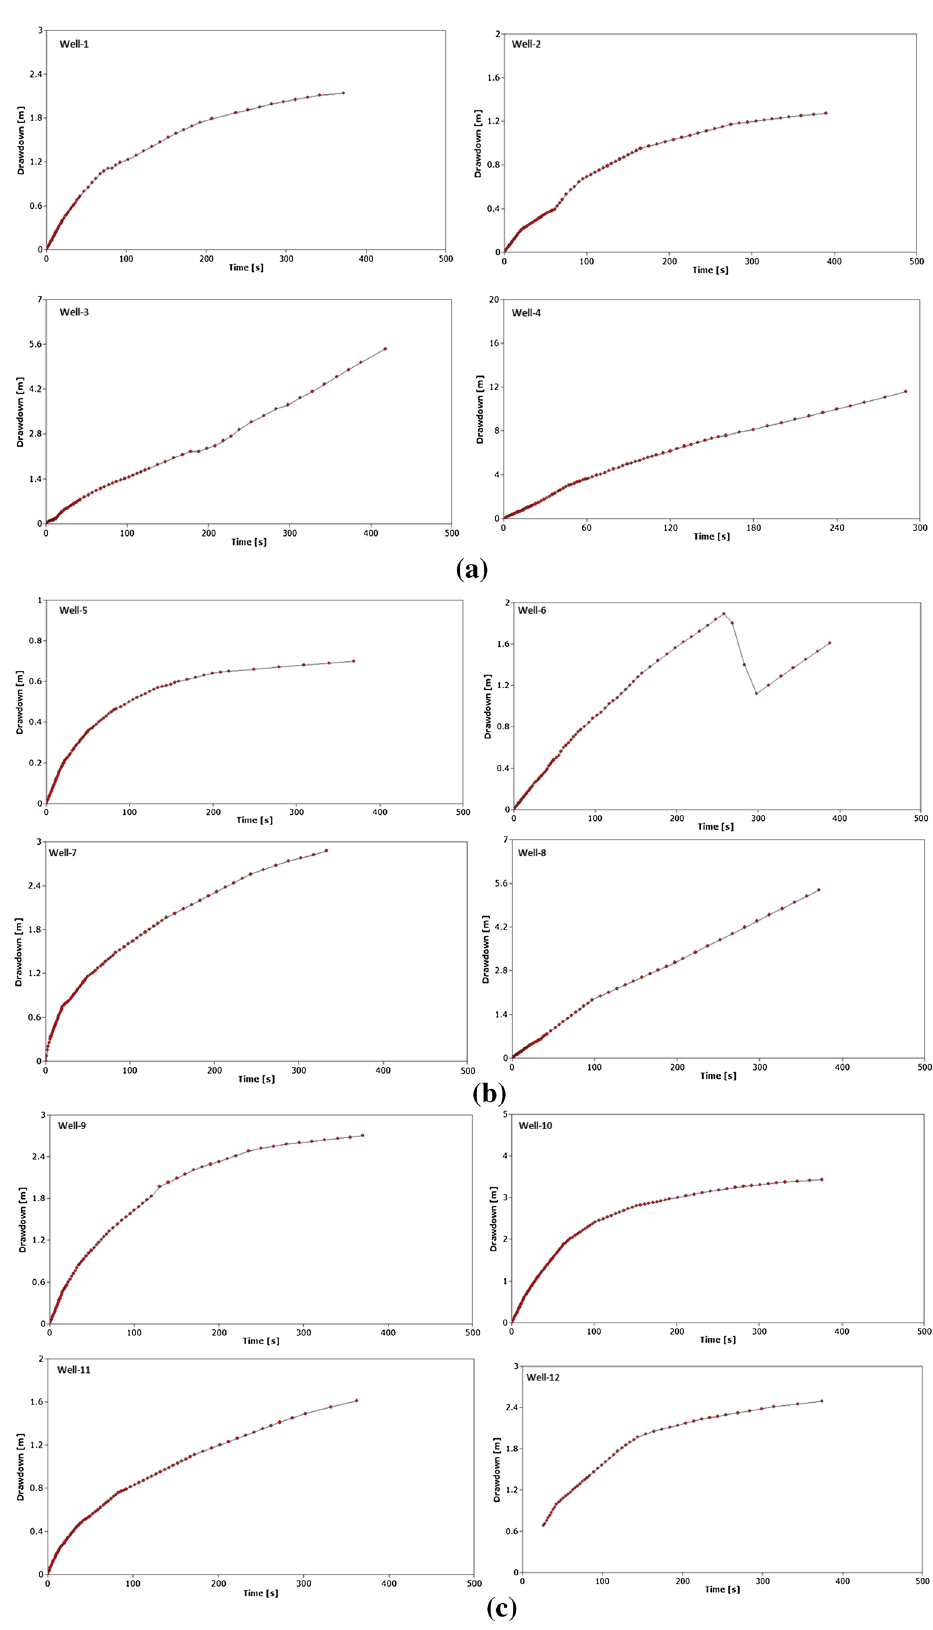
Fig. 5 a Graph of time versus drawdown of well-1 to well-4. b Graph of time and drawdown of well-5 to well-8. c Graph of time and drawdown of well-8 to